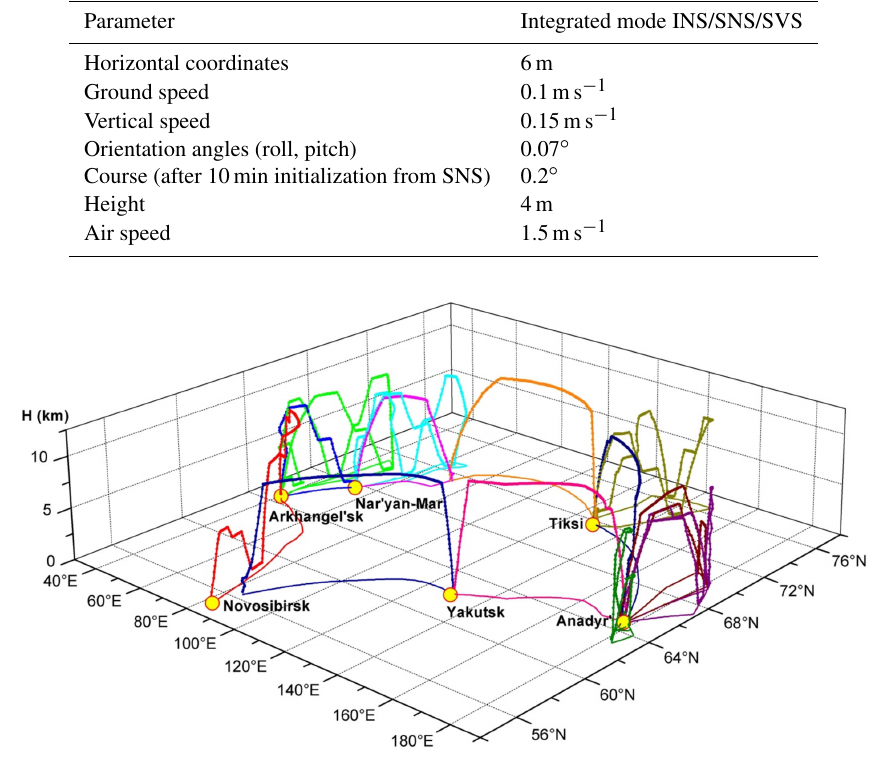
Figure 5. Schematic map of the routes of the Optik Tu-134 aircraft laboratory in the regions of the Russian